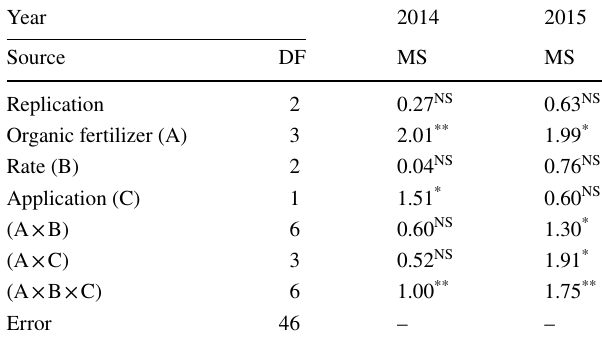
Table 6 Mean square for shoot DM for both years